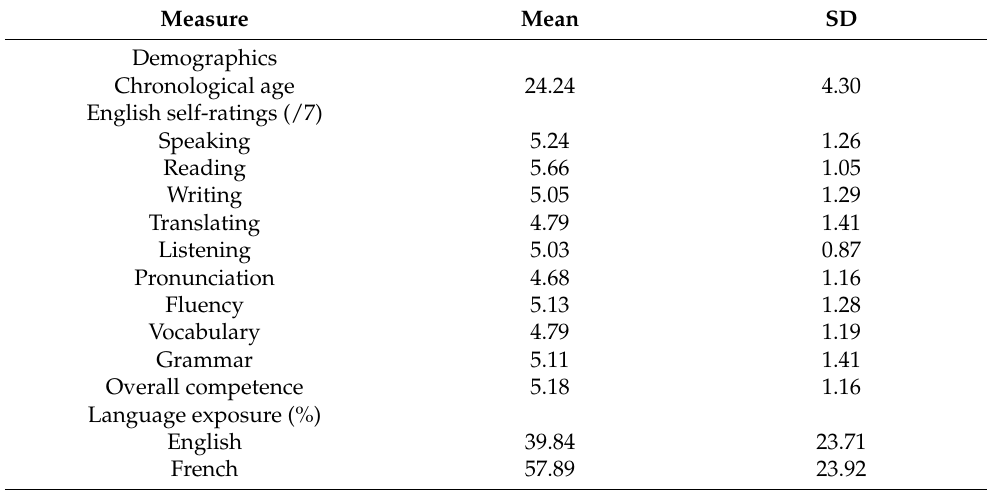
Table 5. Participant characteristics (Experiment 2). Self-ratings were collected on a 1–7 scale